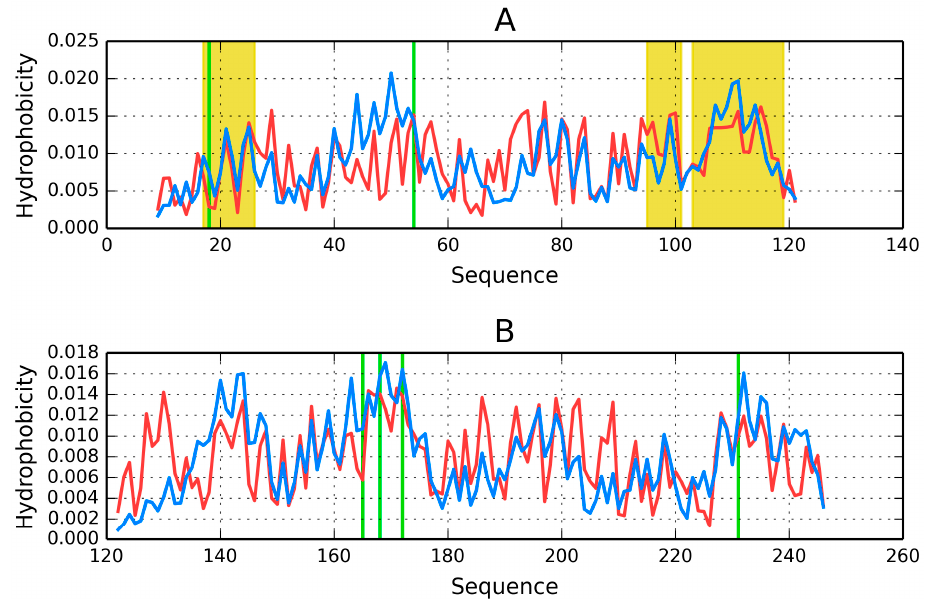
Figure 6. Theoretical (blue line) and observed (red line) hydrophobicity density distribution profiles in dystrophin: A —CH1 (complete domain), B —CH2 (complete domain). Green lines: positions of disease-related mutations, yellow area: fragment interacting with